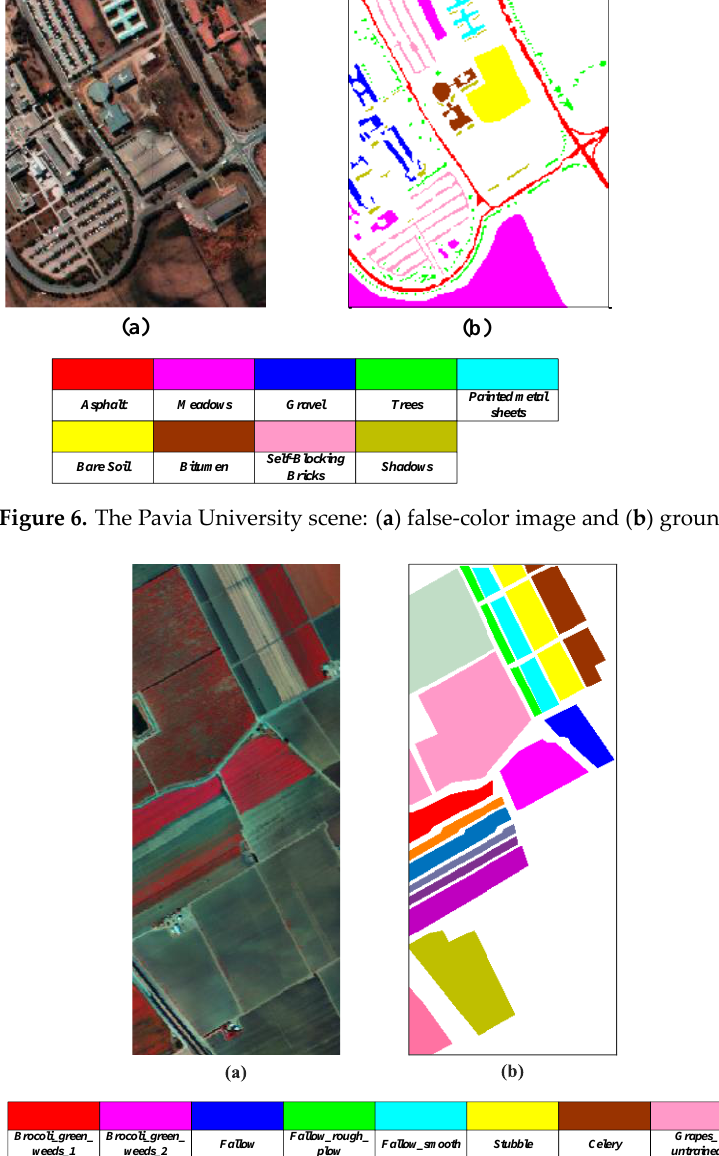
11 of 25 Figure 5. The Indian Pines scene: ( a ) false-color image and ( b ) ground truth map. The second land cover hyperspectral scene is Pavia University. This scene was col-